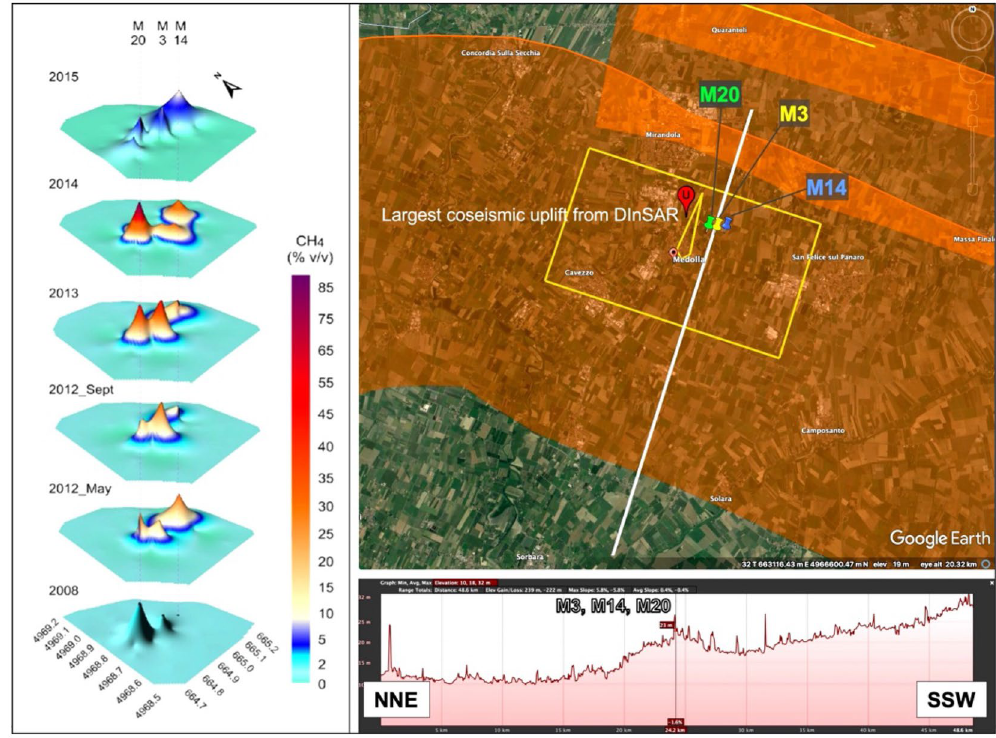
Figure 5. Location of the historically documented Medolla macroseeps. Summary of occurrences in the region of Terre calde (Warm grounds), a set of permanent macroseeps documented historically near Medolla (Modena, northern Italy). Their name relates to the continuous degassing, which eventually heated the ground causing anticipated melting of the snow cover in winter. Left panel): changes in the natural release of CH 4 between 2008 and 2015 for the M3, M14 and M20 emissions 33 . Upper right panel): surface projection of the Individual Seismogenic Source responsible for the 29 May 2012 earthquake, shown in yellow, overlying Composite Seismogenic Sources, in orange (all from the DISS database). The image shows also the culmination of vertical dislocation detected by DInSAR interferometry following the 29 May 2012 Mirandola (Emilia) earthquake 34 , and the exact location of the M3, M14 and M20 emissions. Lower right panel): topographic profile of the area along a NNE-SSW trend (in light gray in the overlying map), showing that the emissions fall on a local altimetric culmination and in the area of largest coseismic uplift. Such mechanism of continuous degassing is most likely due to extrados faulting; a mechanism that has been shown to dominate in the northern Apennines, at the western end of our study area 35,36 , and may be common elsewhere. We contend that a similar mechanism might explain many of our observations over the entire study area, and over any similar areas around the globe. See text for further discussion. Base map and profile courtesy of Google Earth Pro v. 7.3.4.8248, 16 July 2021: map centred on Medolla (Modena, northern Italy), 32 T 663,975.81 m E, 4,968,157.45 m N, elevation 24 m, eye altitude 20.32 km, imagery date 8/18/2014–9/4/2020 (online). Available through: https:// earth. google. com/ web/ (accessed 9 January